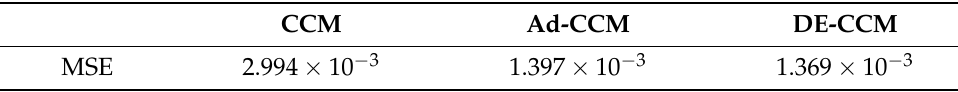
Figure 3. Tracking error under different controllers. Table 1. MSE for state trajectory tracking for the aircraft